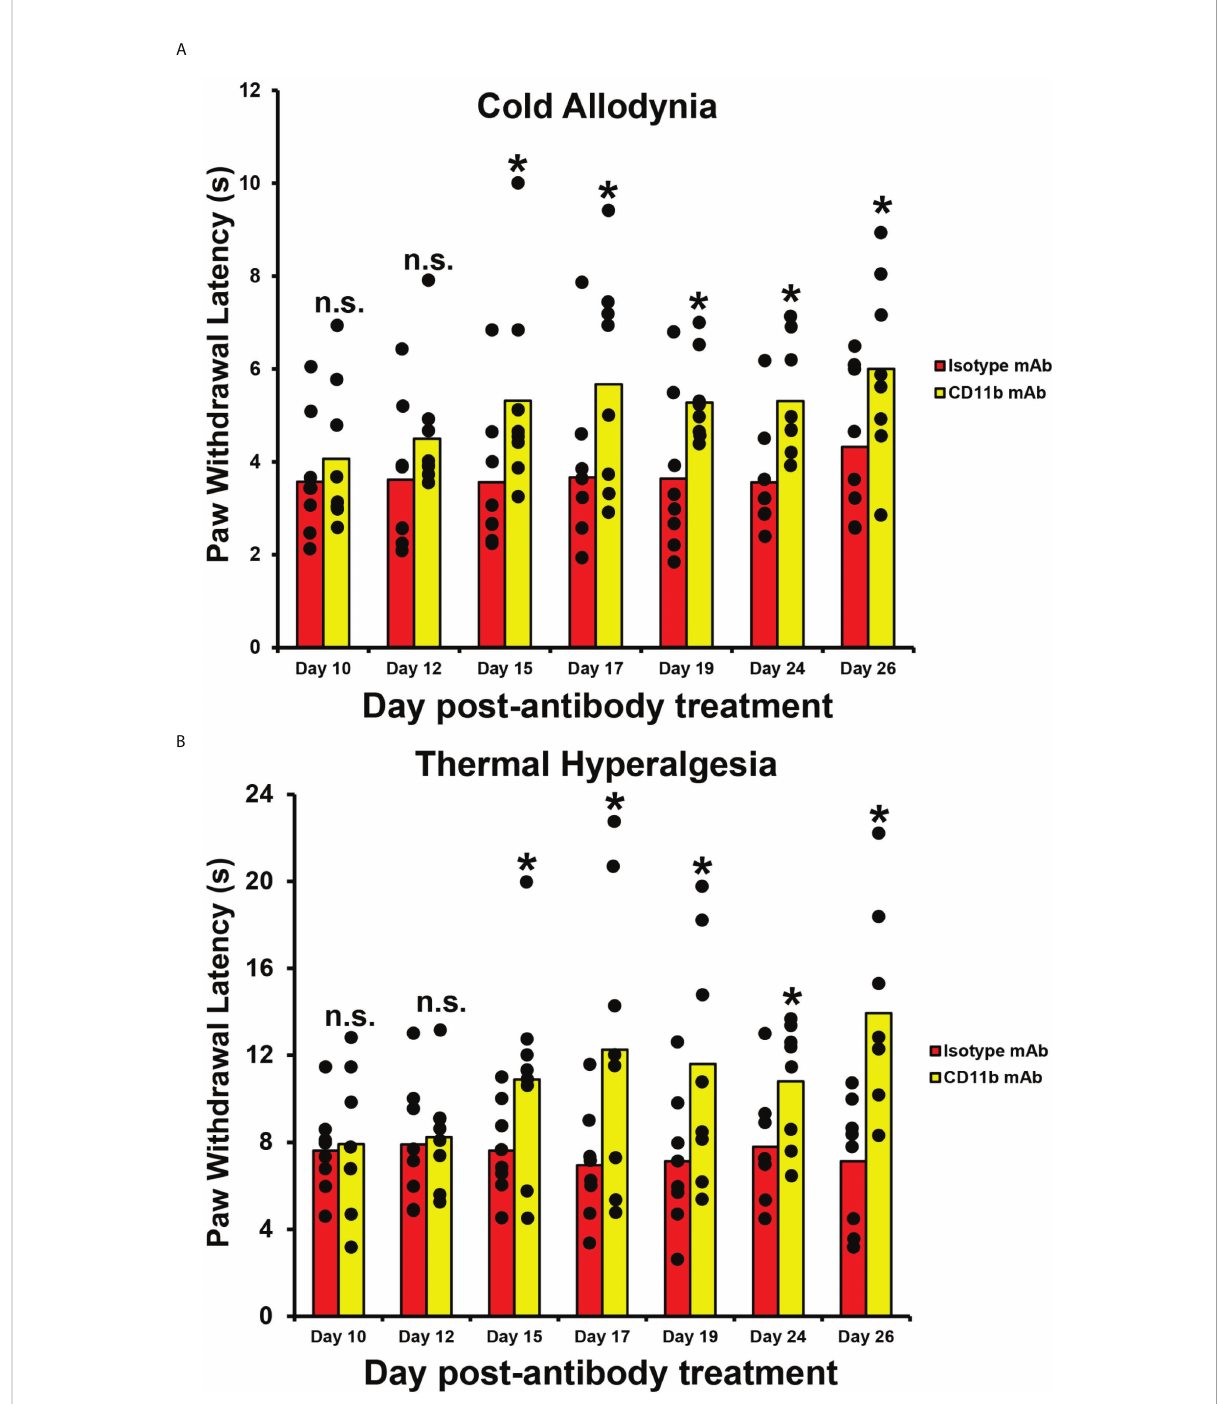
FIGURE 7 Ef fi cacy of CD11b antagonism on chronic nociception in Tamoxifen-induced adult Gdnf CKO mice following unilateral sciatic nerve crush injury. Bar histograms from a representative experiment demonstrate mean paw withdrawal latencies (in seconds) testing for cold allodynia (A) and thermal hyperalgesia (B) following unilateral sciatic nerve injury and subsequent systemic CD11b antagonism. Signi fi cant increases in mean paw withdrawal latencies are observed in mice treated with 5 mg/kg IP of a speci fi c rat anti-mouse CD11b IgG2b monoclonal antibody (CD11b mAb) compared to mice treated with an isotype control antibody (Isotype mAb) from day 15 after last treatment (i.e. day 32 post-injury). Mean uninjured (Sham control) paw withdrawal latency = 5.5 s for cold allodynia (A) and 11.9 s for thermal hyperalgesia (B) . *p < 0.05. n.s. not signi fi cant, N = 8 (4 male and 4 female